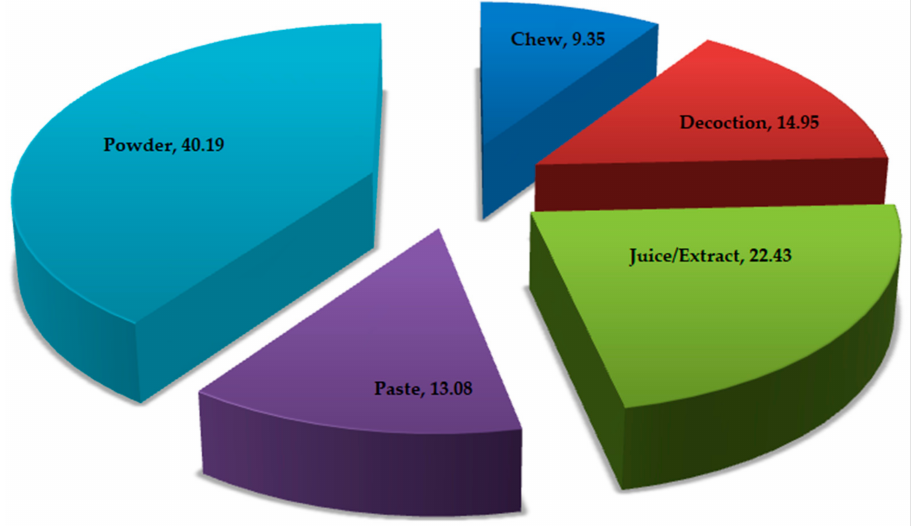
Figure 8. Percentage of different methods of application as a